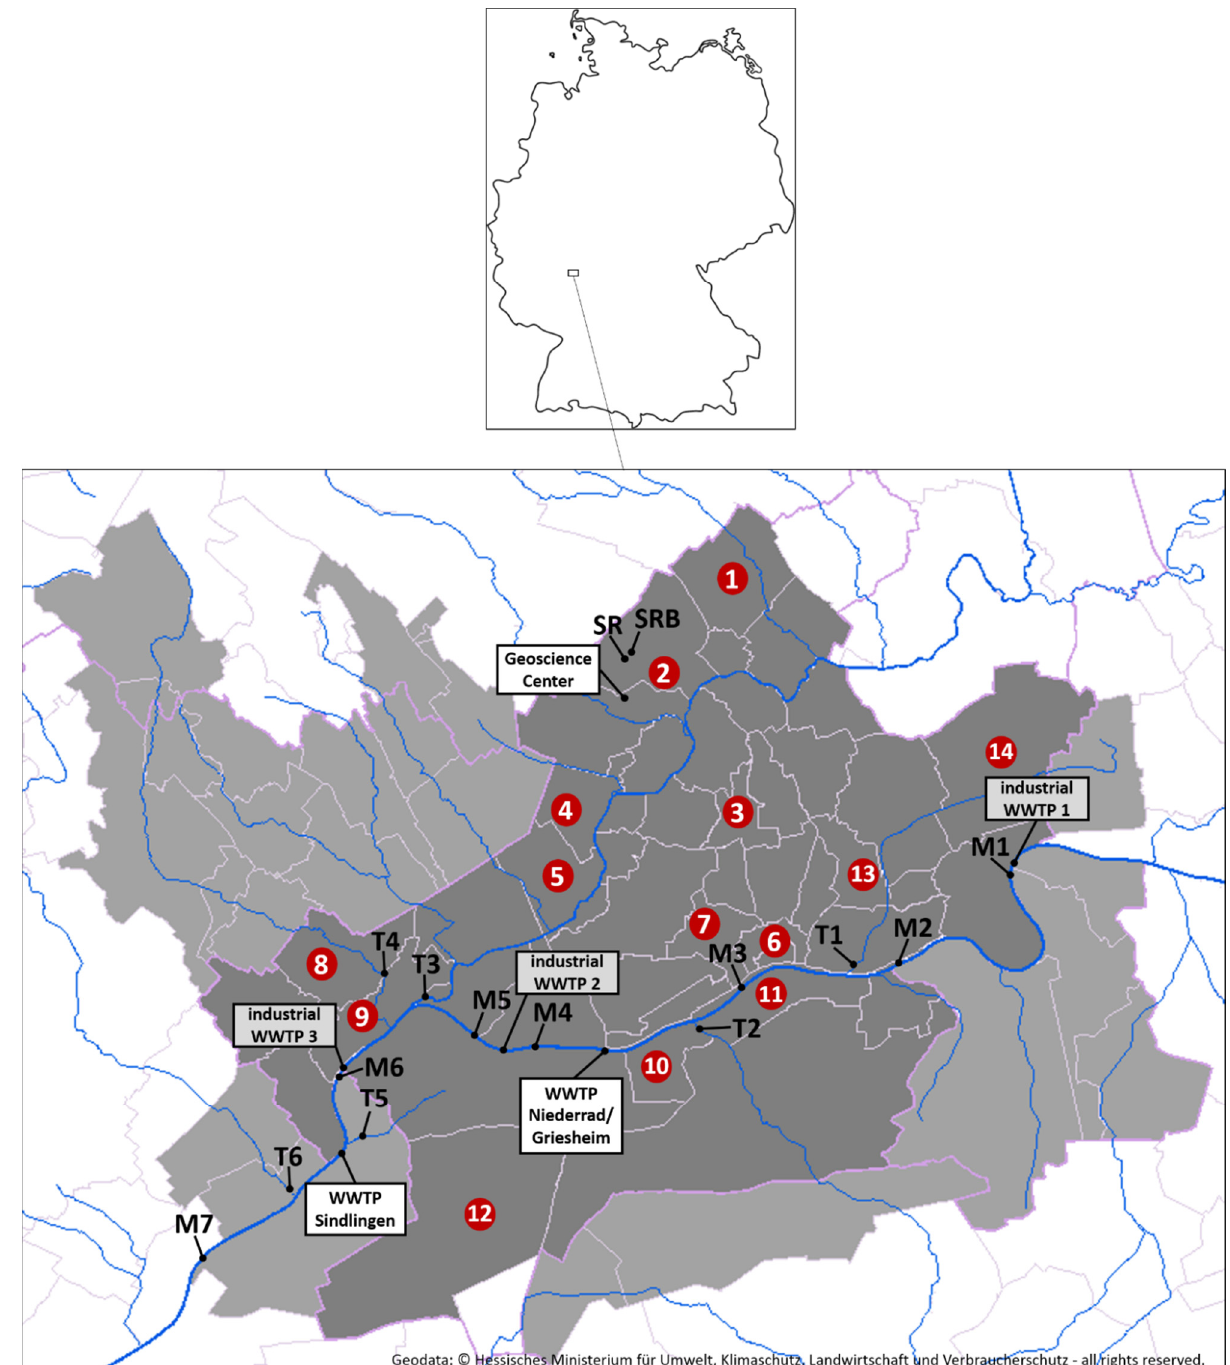
Figure 1. Study area with city of Frankfurt (dark grey) and some adjoining municipalities (light grey), which deliver their sewage water to the two municipal WWTPs of Frankfurt am Main (Niederrad/Griesheim and Sindlingen). Additionally, locations of three industrial WWTPs discharging their wastewater into the river Main are shown. Sampling locations at river Main are indicated by M1–M7 and sampling locations of tributaries by T1–T6. Numbers in red dots indicate the urban district where drinking water samples have been collected. SR = sampling point for surface runoff, SRB = sampling point of stormwater retention